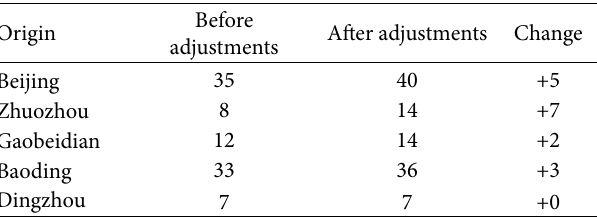
Table 4: Accessible cities for 5 origins before and after adjusting timetable.